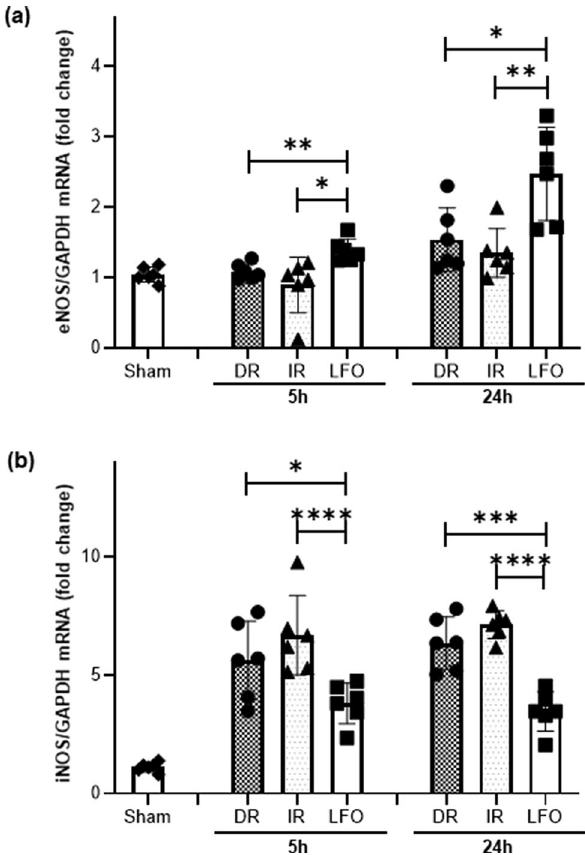
Figure 5. Effect of TNS-induced CBF oscillations at 0.1 Hz on NOS isoforms mRNA expression in peri- contusional brain tissue at 5 h and 24 h after TBI + HS. ( a ) eNOS. ( b ) iNOS. All of the data are presented as mean ± SD, and compared by one-way ANOVA and Student–Newman–Keuls test. n = 5–7/ group. DR: delayed resuscitation; IR: immediate resuscitation; LFO: low frequency oscillation in